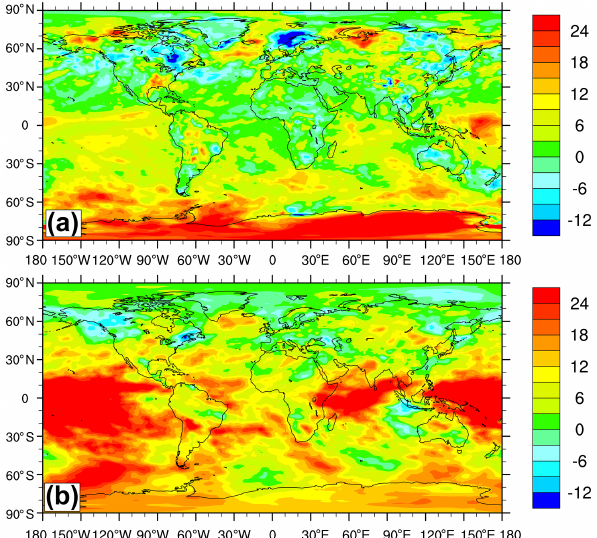
Figure 17. Mean relative difference (%) between the hydroxyl rad- ical (OH) predicted using the new lightning flash-rate parameterisa- tions (Run 2) and the default PR92 parameterisations (Run 1): (a) at 20m (the lowest model level) and (b) at 6400m ( ∼ 450hPa).